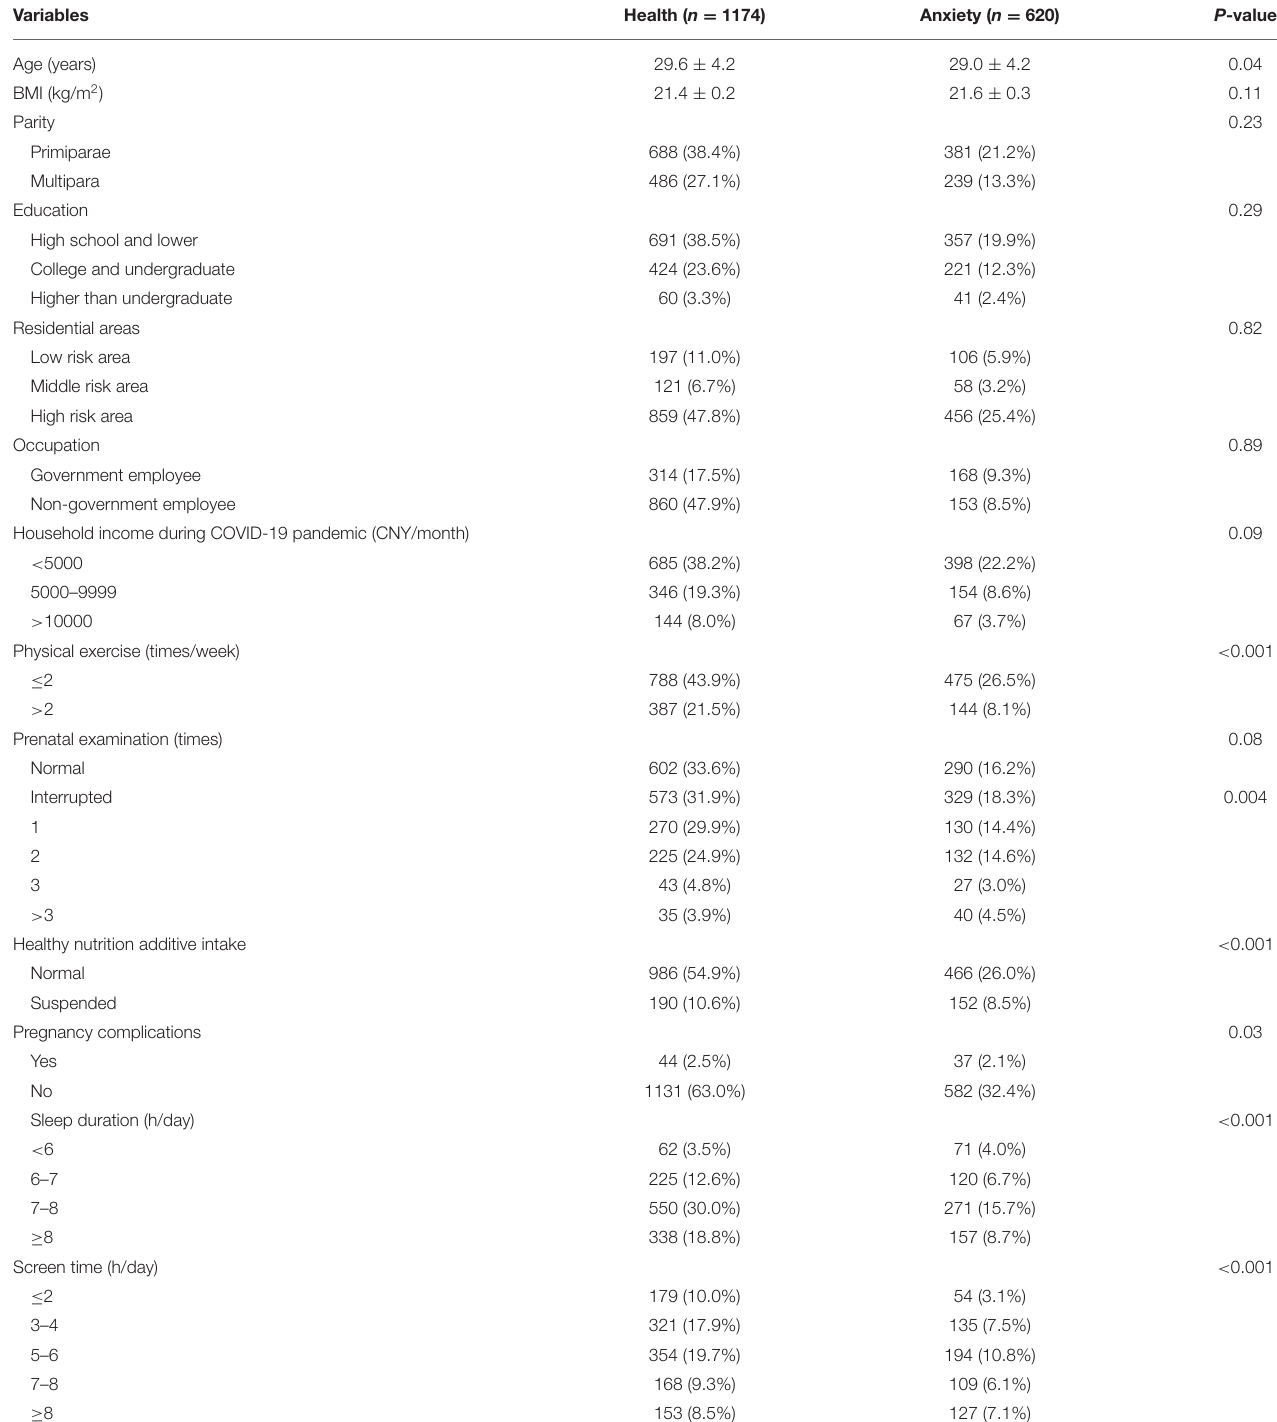
TABLE 1 | General characteristic of pregnant women in health and anxiety group.